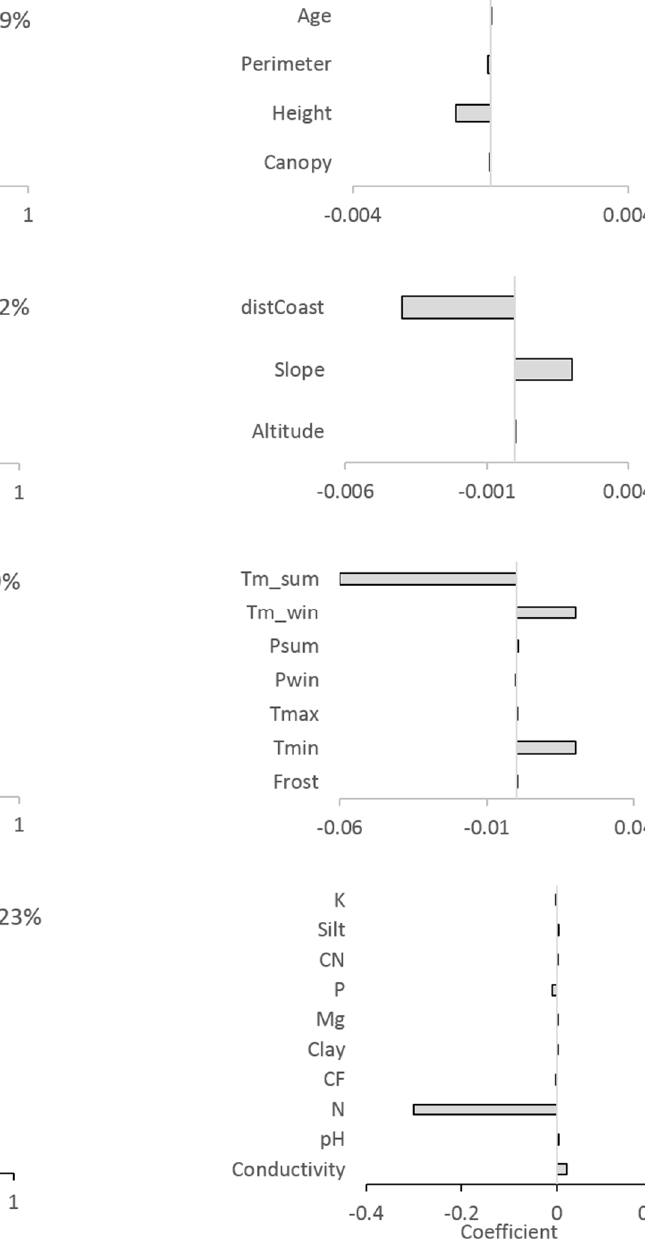
Figure 3. The relative importance ( a ) and the estimated coefficients ( b) of variables estimated across all fitted GLM models using a multi-model average approach for the Canker symptom. We also indicate the percentage of deviance explained by each complete model.